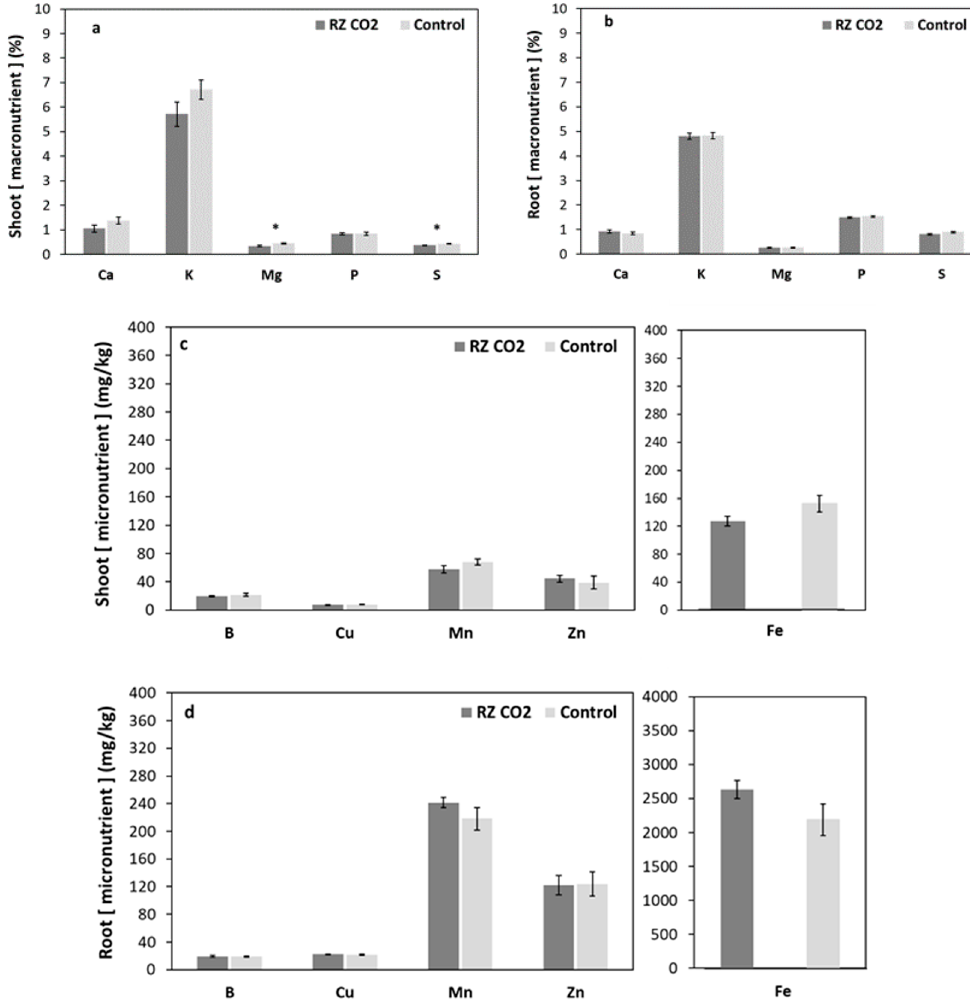
Figure 2. Elevated RZ CO 2 e ff ects on lettuce shoot ( a ) and root ( b ) macronutrients concentrations: calcium (Ca), potassium (K), magnesium (Mg), phosphorus (P) and Sulphur (S). Shoot ( c ) and root ( d ) micronutrients concentrations: boron (B), copper (Cu), iron (Fe), manganese (Mn) and zinc (Zn). Experiment 7. Bars are means ± SE of 8 replicates. Asterisks indicate significant di ff erences between treatments (Independent Sample T-test, p -value < 0.05).